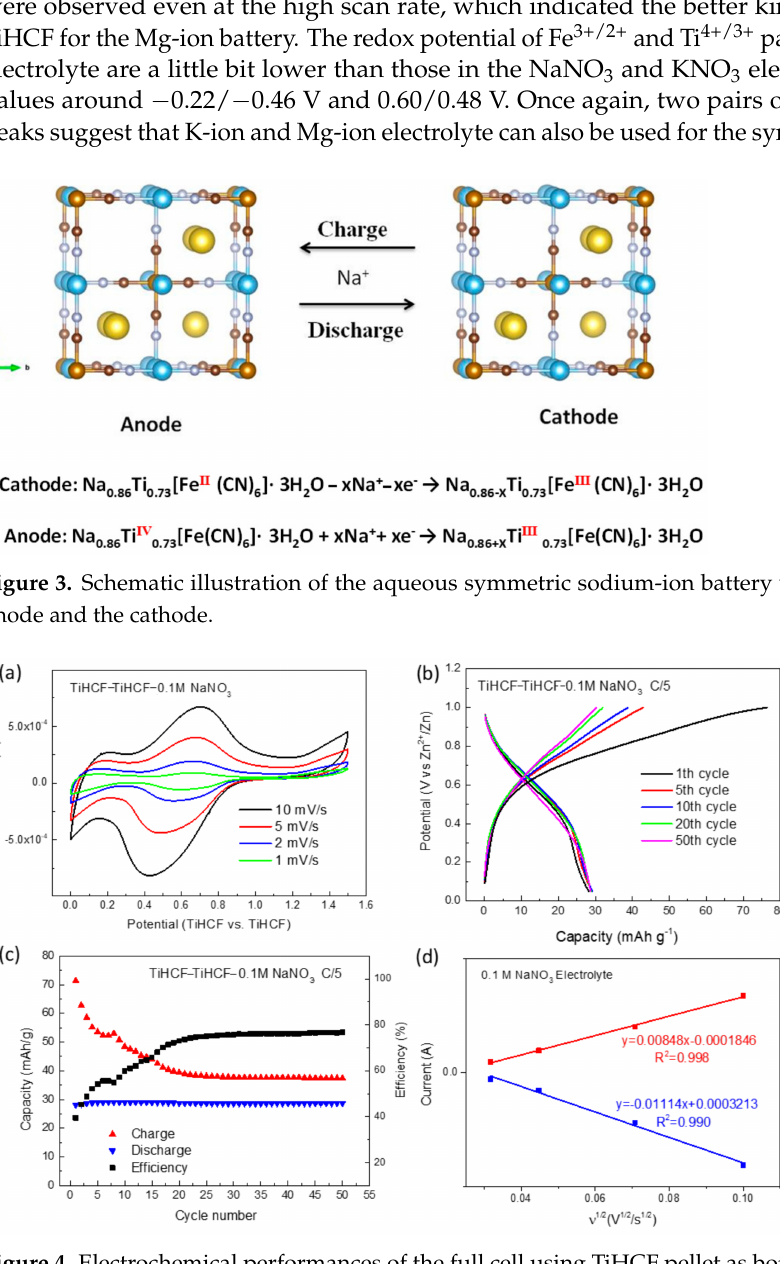
Figure 4. Electrochemical performances of the full cell using TiHCF pellet as both the cathode and anode material at the potential range 0~1.5 V in 0.1 M NaNO 3 electrolyte. ( a ) CV curves at different scan rate; ( b ) Galvanostatic charge–discharge profiles at C/5; ( c ) cycling performance of the full cell at C/5; ( d ) relationship between the peak currents ( I p ) and scanning rate ( v 1/2